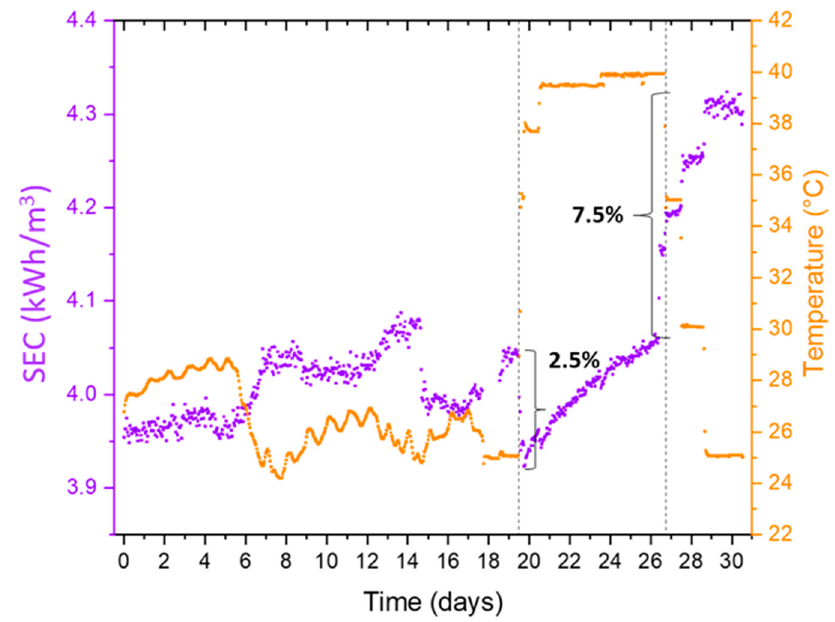
Figure 7. Variations in specific energy consumption (SEC) during the pilot test.